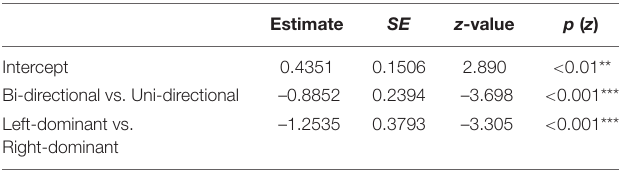
TABLE 4 | The results of a logistic regression model for the response accuracy among Mandarin speakers.